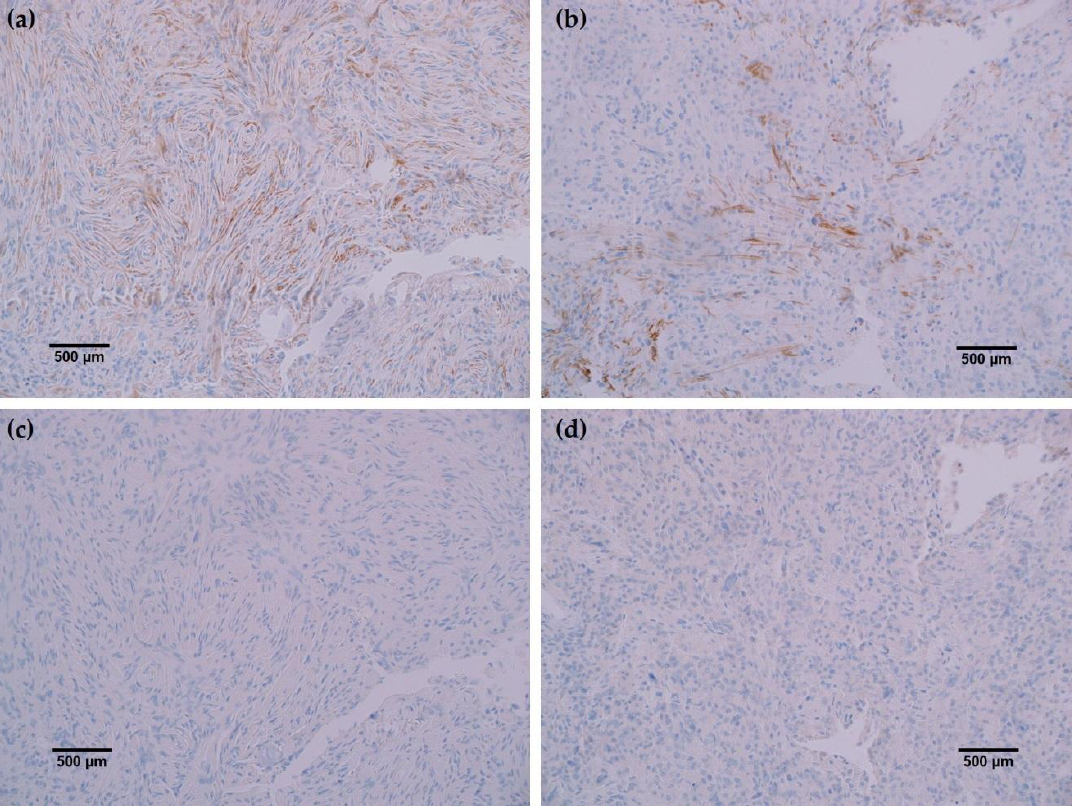
Figure 6. Comparison immunohistochemistry (IHC) staining results of MRQ-67 and H09 in meningioma specimens: ( a ) The H09 clone displayed positive reactivity in spindle cells of a meningioma sample (200×); ( b ) Positive labeling of fine fibrous elements by the H09 clone in another case of meningioma (200×); ( c ) The MRQ-67 clone demonstrated no cross-reactivity with spindle cells in the same meningioma case stained with the H09 clone (200×); ( d ) MRQ-67 also did not generate cross-reaction with fibrous elements as was observed with H09 staining in the same case of meningioma (200×).